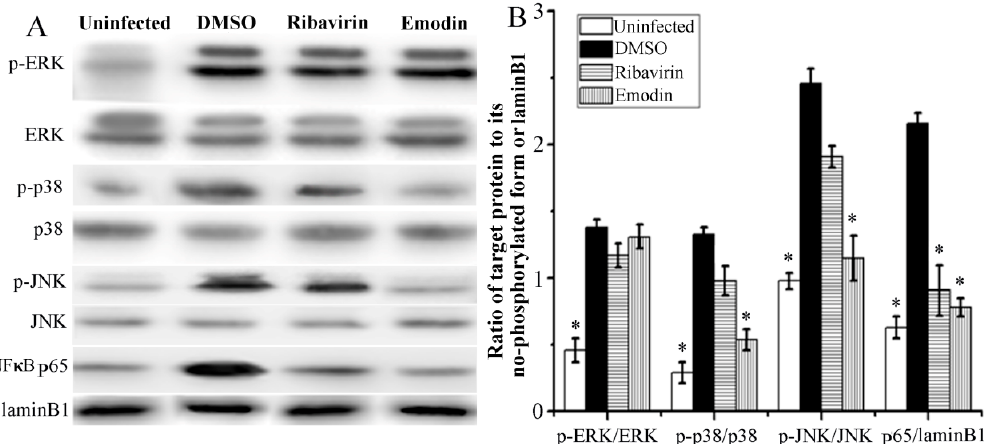
Figure 3. Effect of emodin on the activations of MAPKs and NF- κ B signaling pathways after IAV infection. The treatments were same as those of Figure 2. Phosphorylations of ERK, p38, and JNK MAPKs and nuclear translocation of NF- κ B p65 were determined by western blotting. ( A ) was the result of the western bolt, and ( B ) was the statistical result of ( A ) analyzed by Quantity One software (Bio-Rad Laboratories, Hercules, CA, USA). All data shown were mean ± SD of five independent experiments. * p < 0.05 vs. the DMSO control.